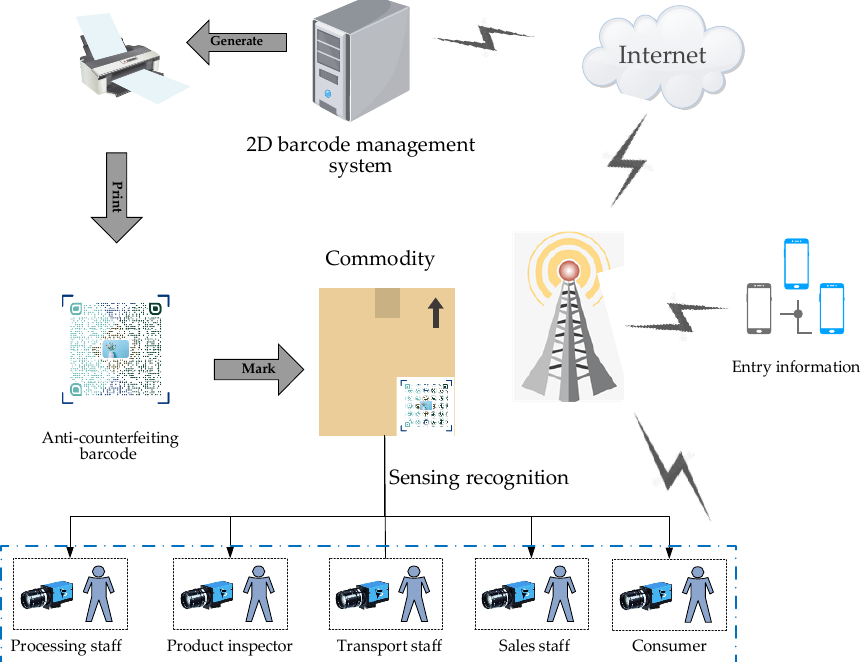
Figure 1. Anti-counterfeiting traceability system topology with 2D barcode sensing recognition.